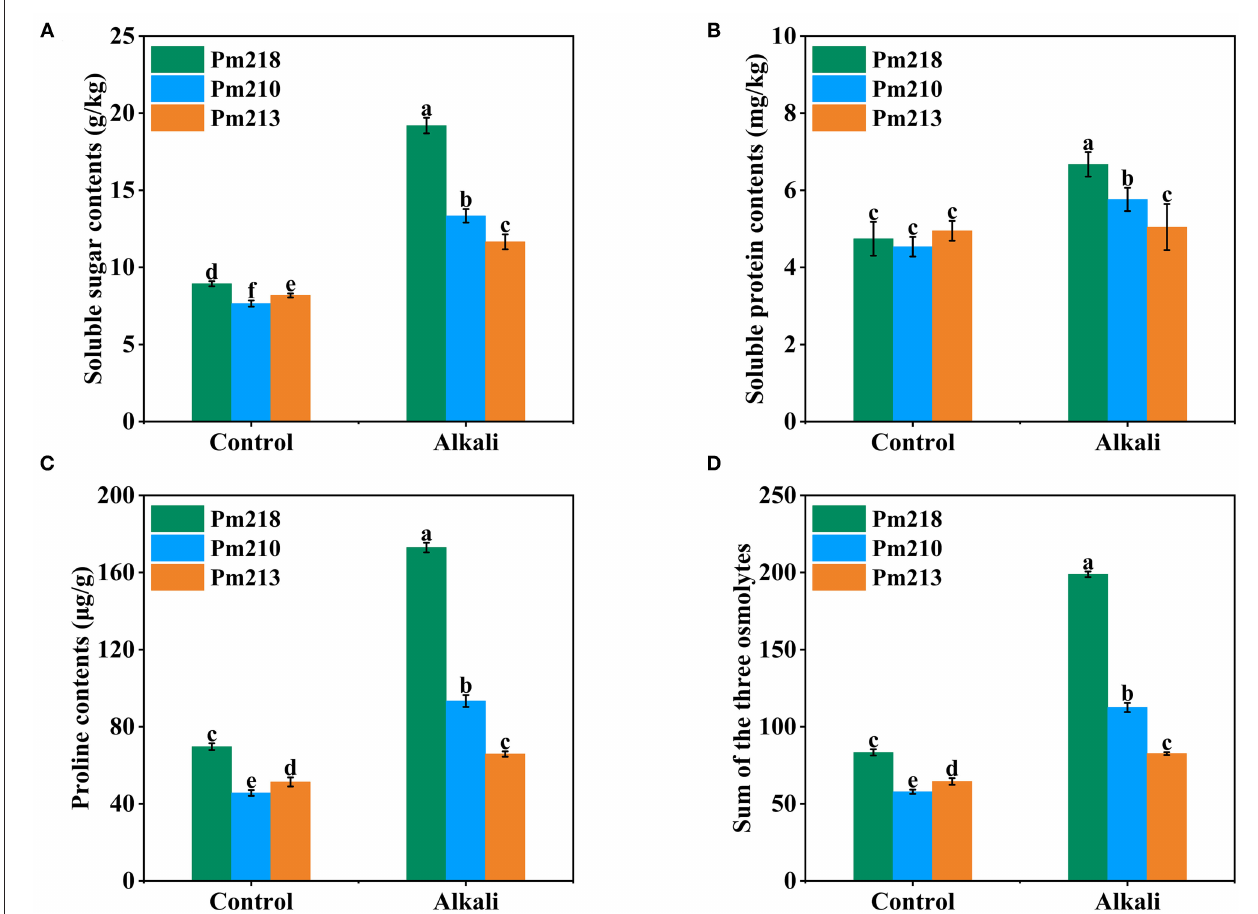
FIGURE 6 | Soluble osmolytes of three genotypes under control (CK) and alkali stress in seedling leaves. (A) Soluble sugar contents. (B) Soluble protein contents. (C) Proline contents. (D) Sum of the three osmolytes. Different letters indicate significant differences ( P < 0.05).